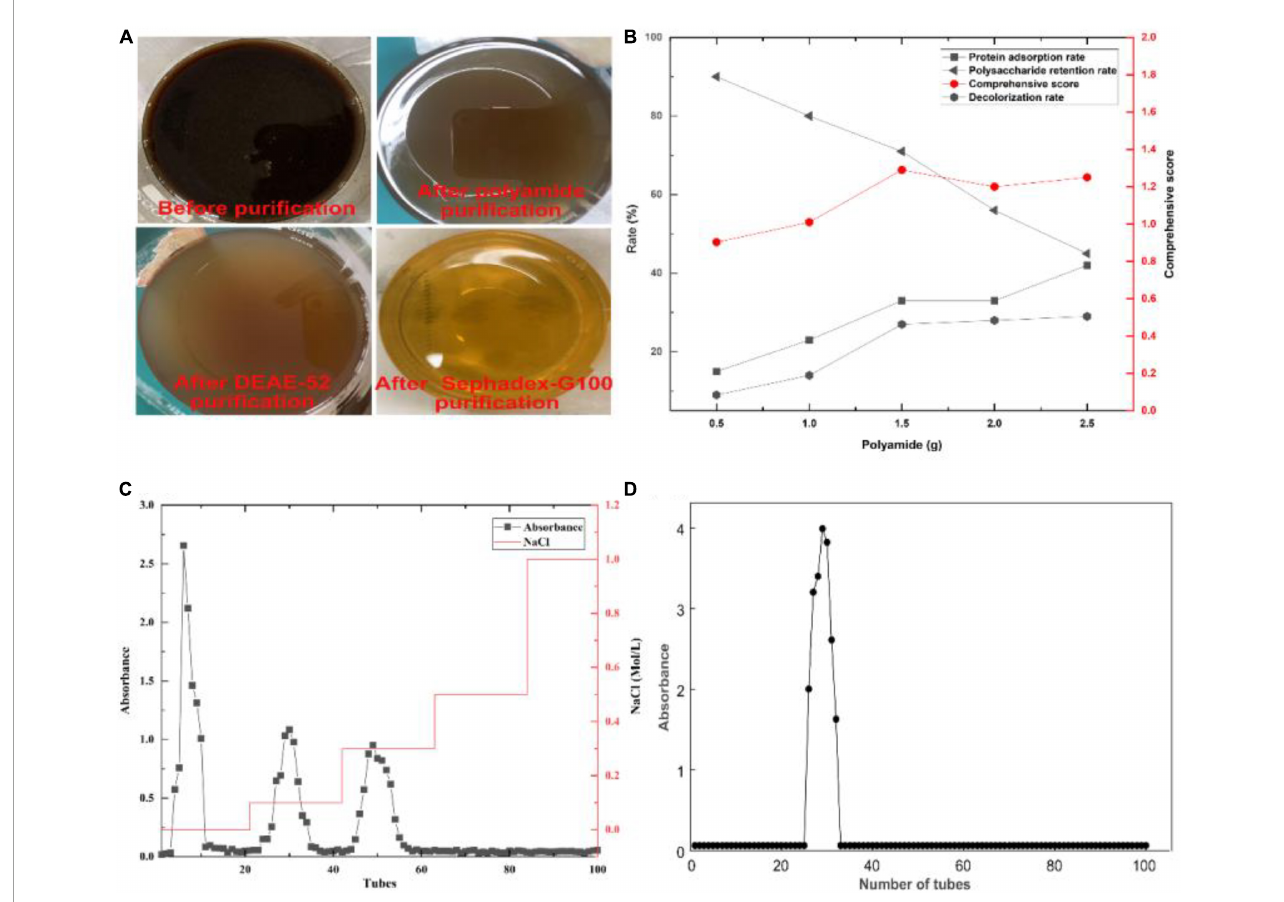
FIGURE3 Crude GFP was purified using a three-step purification method. (A) Change in color during purification. (B) Changes in protein, color, polysaccharide, and comprehensive score during polyamide purification. (C) Three components were generated during the separation and purification of DEAE-52. (D) The elution result of GFP by Sephadex